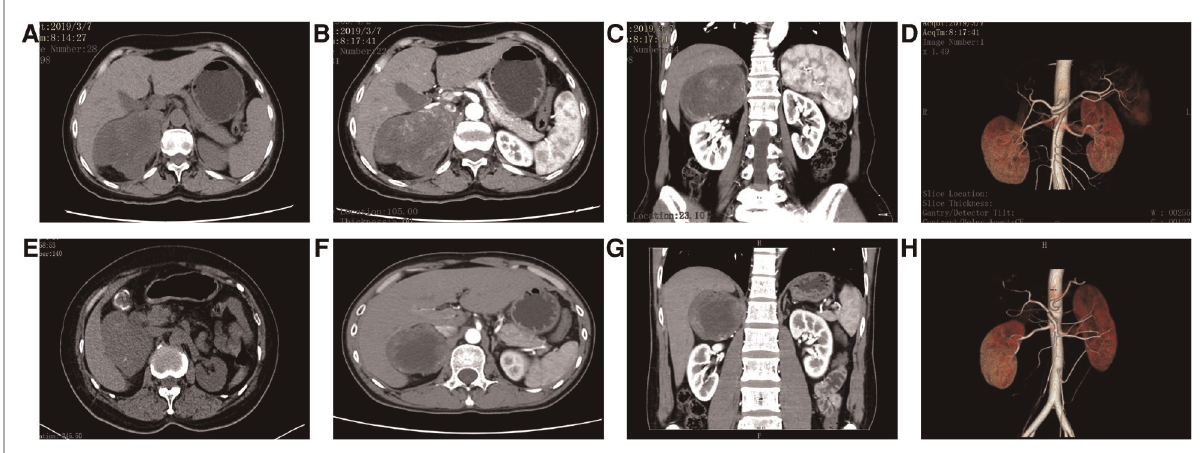
FIGURE 1 CT images of some patients. ( A – D ) Case 1: A mass-like mixed-density shadow was seen in the right adrenal area, and the boundary was still clear. The contrast-enhanced scan showed inhomogeneous progressive enhancement; the focus was mainly supplied by the small artery from the abdominal aorta, and the right renal artery was depressed. ( E – H ) Case 6: The mass density in the right adrenal area was slightly lower and the boundary was clear; the enhanced scan showed mild to moderate enhancement at the edge of the lesion, no enhancement in the central necrotic area, and compression changes in the liver and right kidney. The focus was mainly supplied by the right middle adrenal artery and inferior artery. Part of the blood vessels entered the mass, and the right renal artery moved downward under